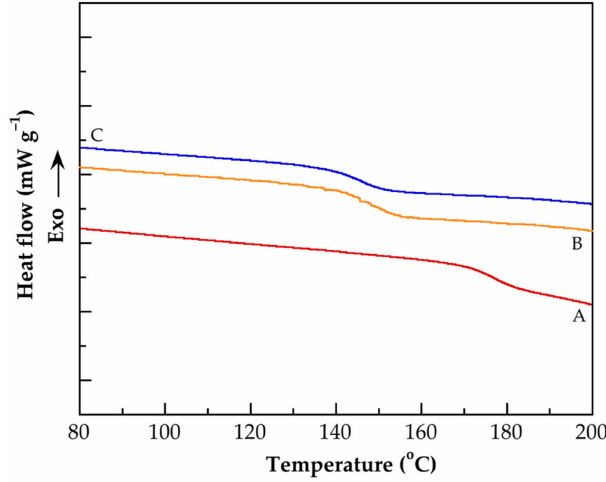
Figure 12. DSC thermograms of PMAA 5 ( A ), and of their nanocomposites: PMAA-G 3.0 -CNTs 10 ( B ), and PMAA-G 3.0 -CNTs 9 ( C